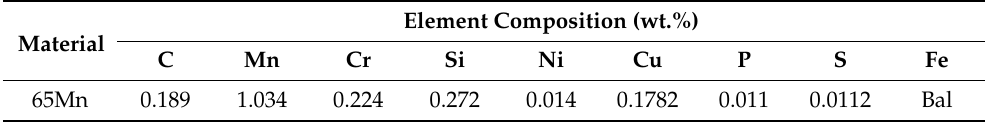
Table 1. Elemental composition of 65Mn blade.